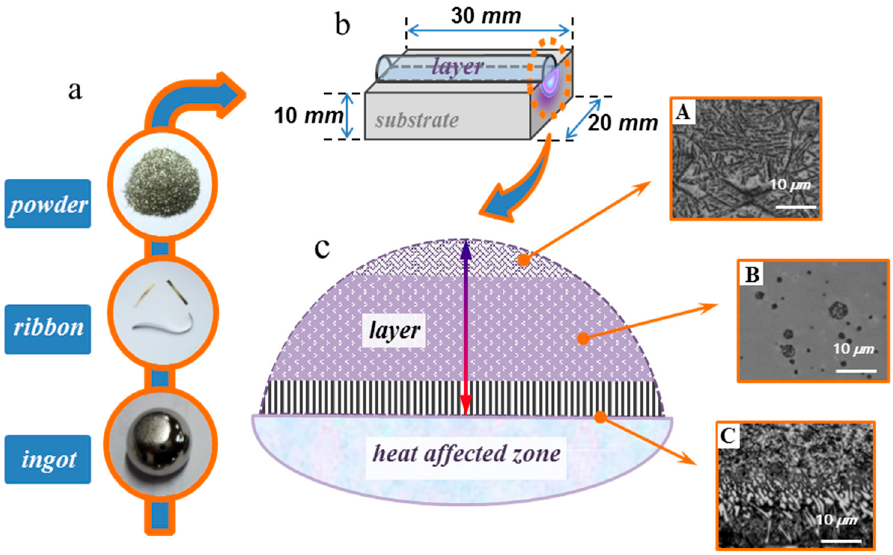
Figure 1. Laser cladding process including: ( a ) Preparation of the cladding alloy; ( b ) cladding sample; ( c ) cross ‐ section views of different regions in the clad.